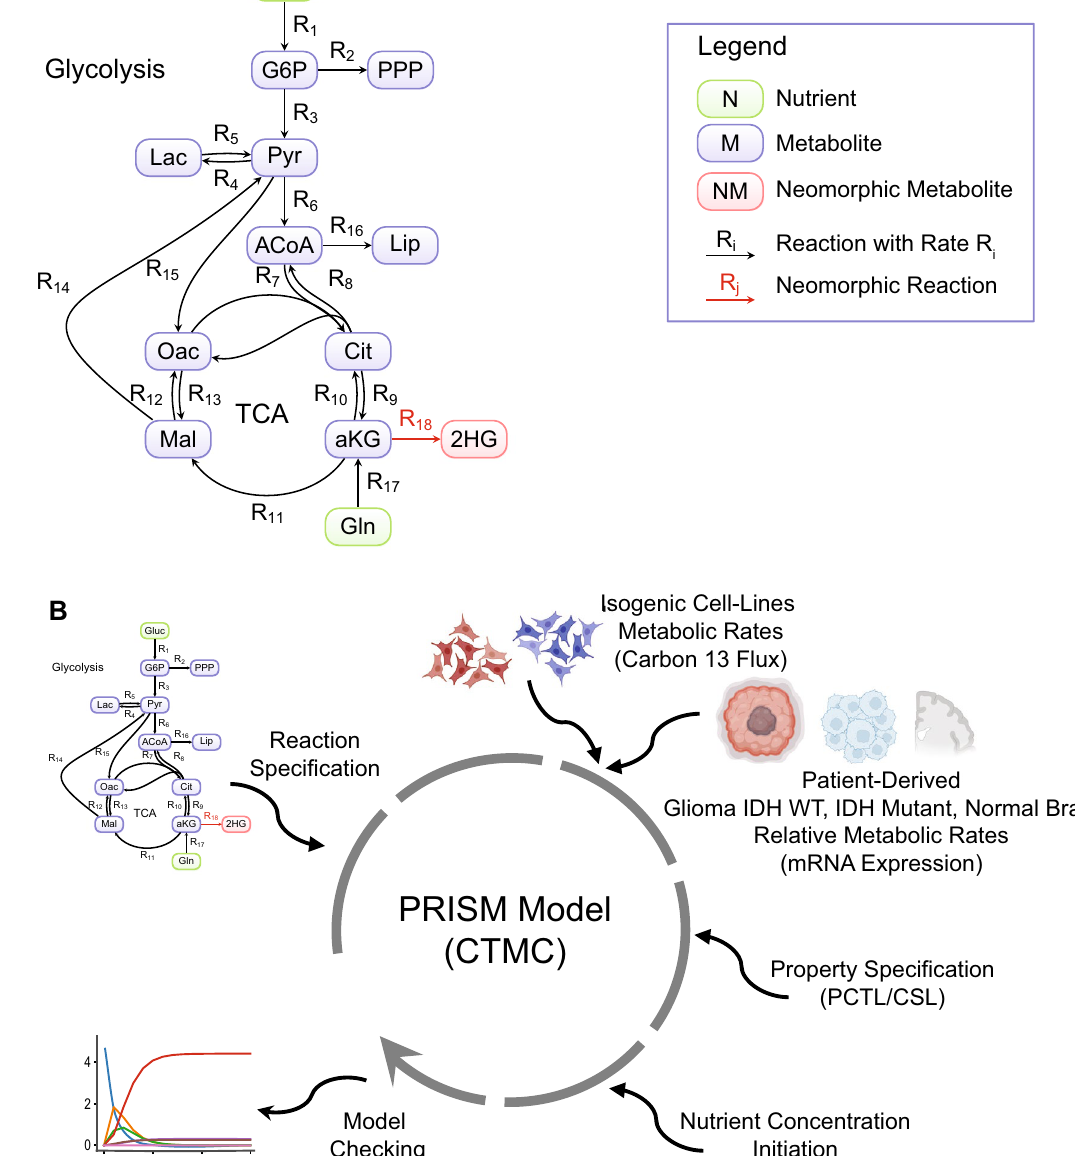
Figure 1. Modeled pathway and model creation workflow. ( A ) Glycolysis and TCA cycle reactions modeled, including neomorphic activity of IDH Mutant. For glycolysis the following metabolites and abbreviations were used: Gluc, glucose; G6P, glucose-6-phosphate; Pyr, pyruvate; Lac, lactate; ACoA, acetyl-CoA; PPP, pentose phosphate pathway; Lip, lipids. For TCA cycle the following metabolites and abbreviations were used: Gln, glutamine; Cit, citrate; aKG, alpha-ketoglutarate; Mal, malate; Oac, oxaloacetate; 2HG, 2-hydroxyglutarate. ( B ) Workflow of PRISM model creation: specification of reactions; instantiation of rates with Grassian et al. 14 metabolic flux rates of isogenic colorectal carcinoma cell lines (with the parental cell line have IDH wild type, and a derived cell line with induction of IDH mutation expression) under normoxia and hypoxia; use of TCGA mRNA expression from patient derived glioma (IDH WT and IDH Mutant) and normal brain to estimate relative rates of metabolic activity for the pairs; specification of properties in probabilistic logic; instantiation of nutrient concentration; model checking of resulting